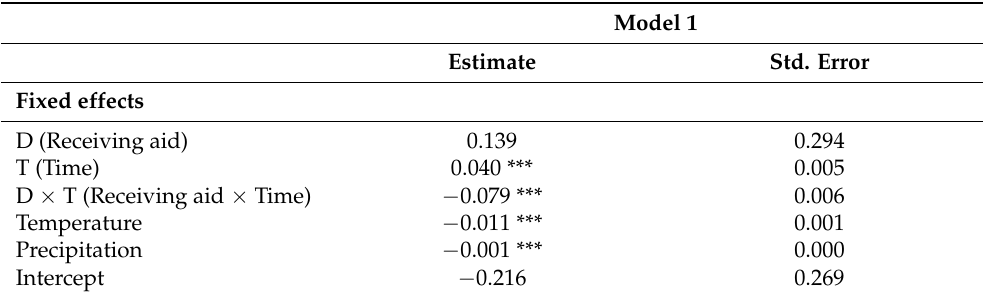
Table A1. Causal effect of agricultural aid on forests with control variables of temperature and